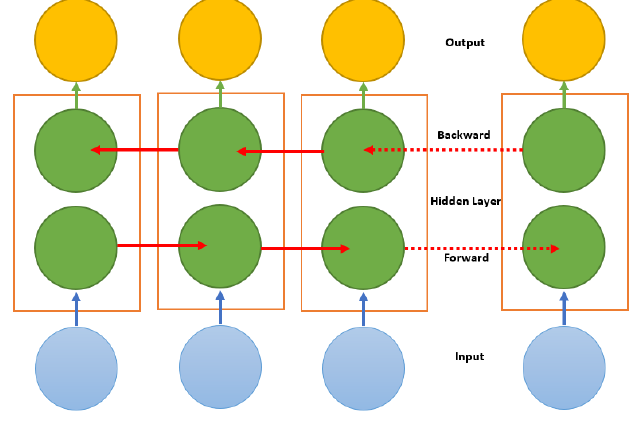
Figure 10. Bidirectional long short-term memory